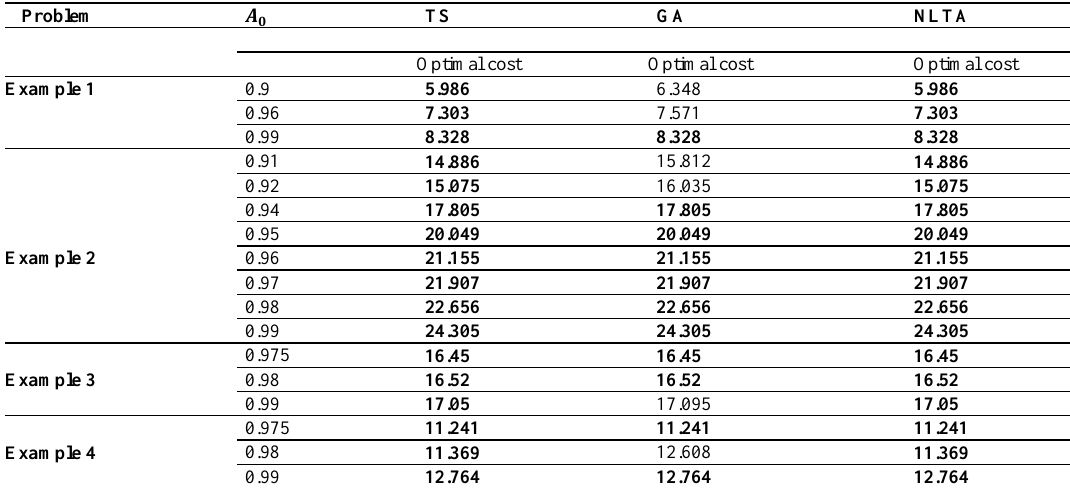
Table 2. Comparison